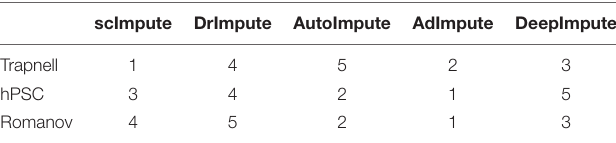
TABLE 2 | The ranking of clustering effects on the real data